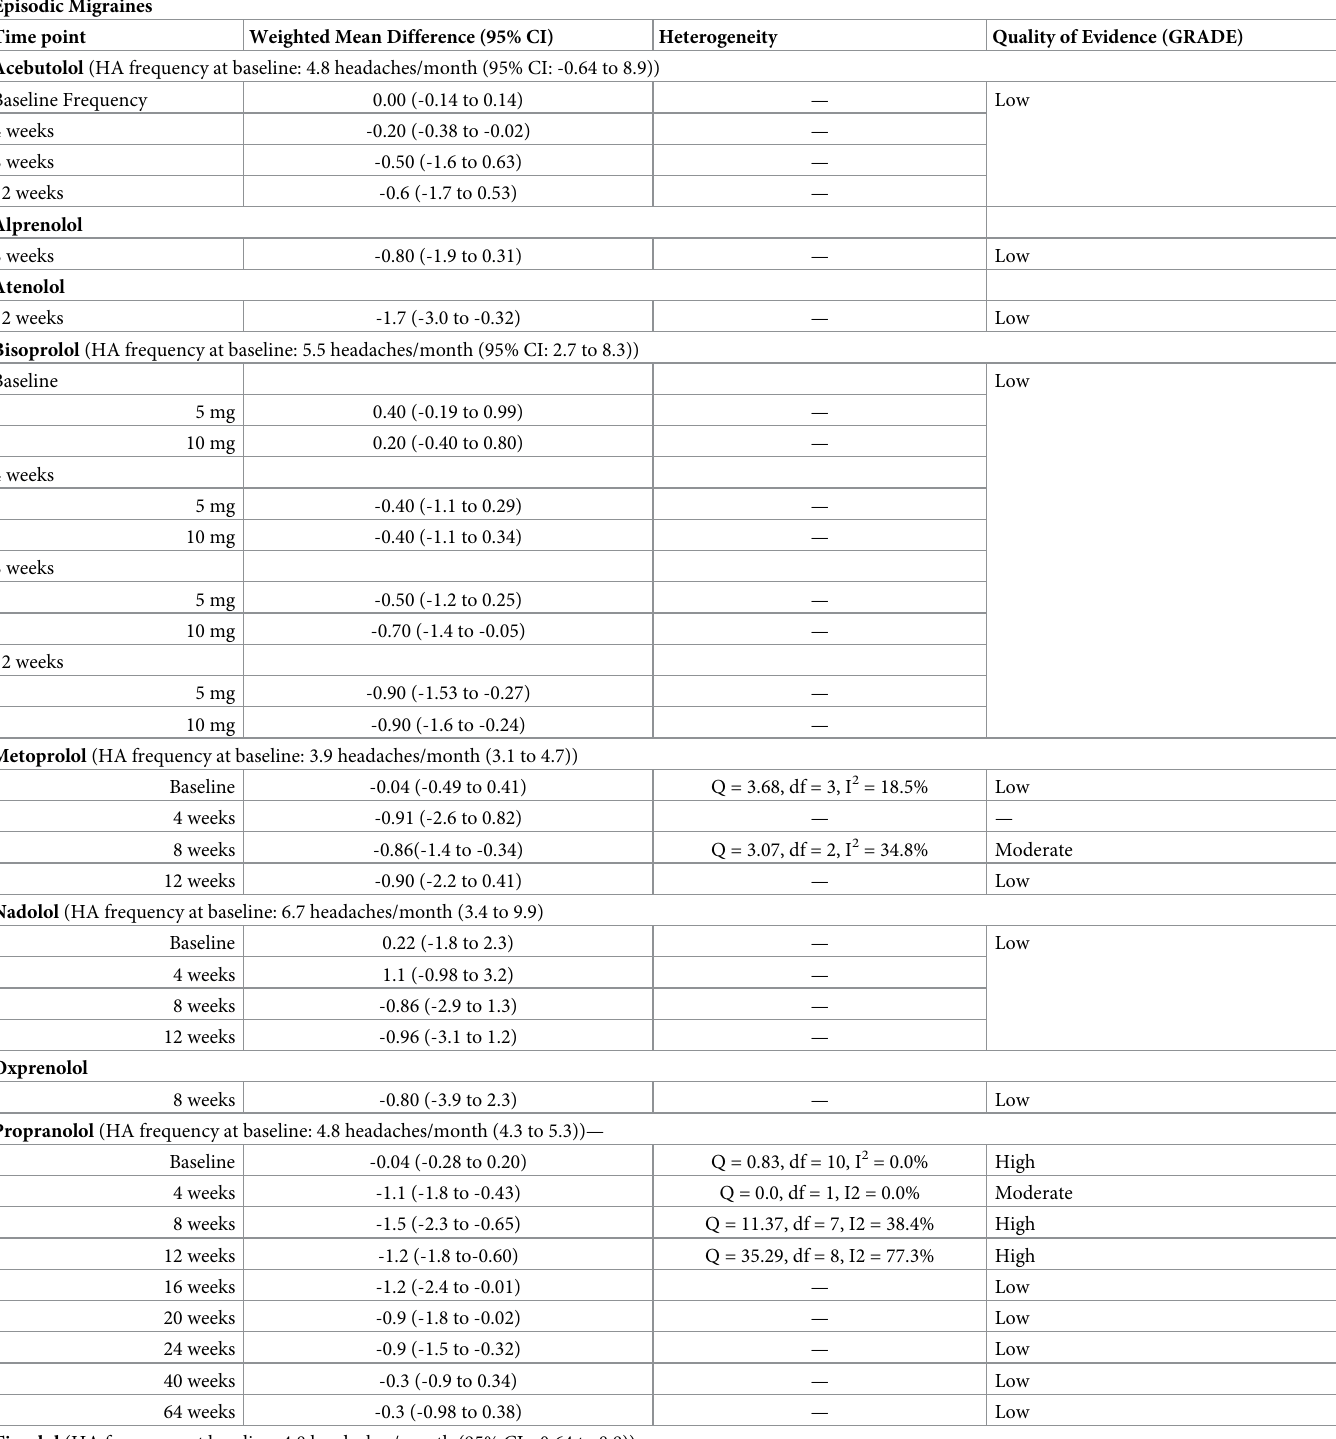
Table 2. Placebo controlled primary outcome (headache frequency per